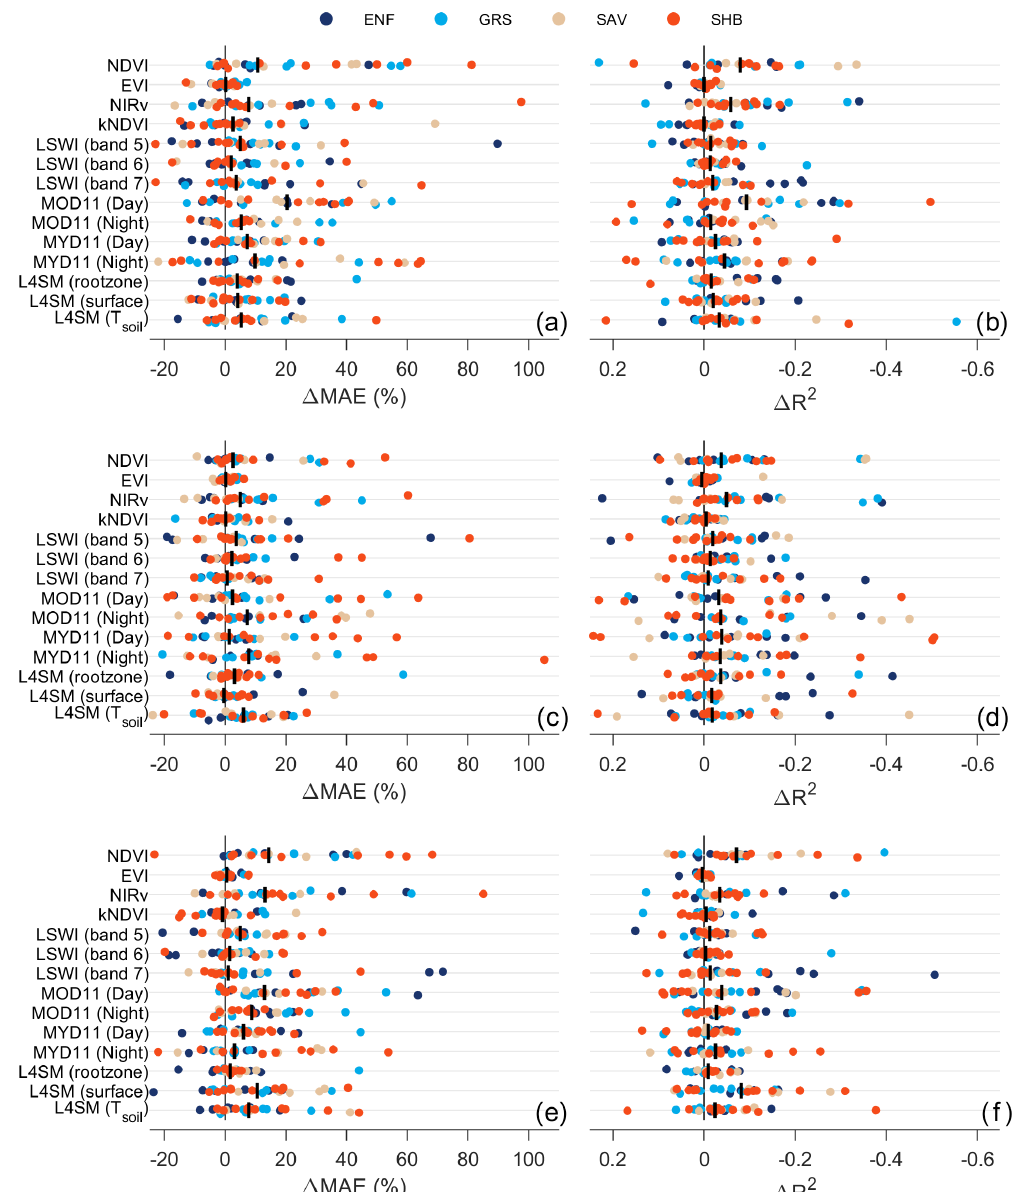
Figure 9. Site-level (filled circles, colored by vegetation type) and median (vertical black line) change in MAE ( (cid:49) MAE) and R 2 ( (cid:49)R 2 ) for DrylANNd model predictions of (a,b) GPP, (c,d) NEE, and (e,f) ET when the information content of each variable is destroyed via random permutation. For each site, 100 random permutations of each variable were performed (each with the same mean and variance as the original variable), model predictions were generated with a randomly selected ANN (whose site was excluded from model calibration) from the ensemble for each noise-only permutation, and predictions with the noise-only simulation were compared to those with the original